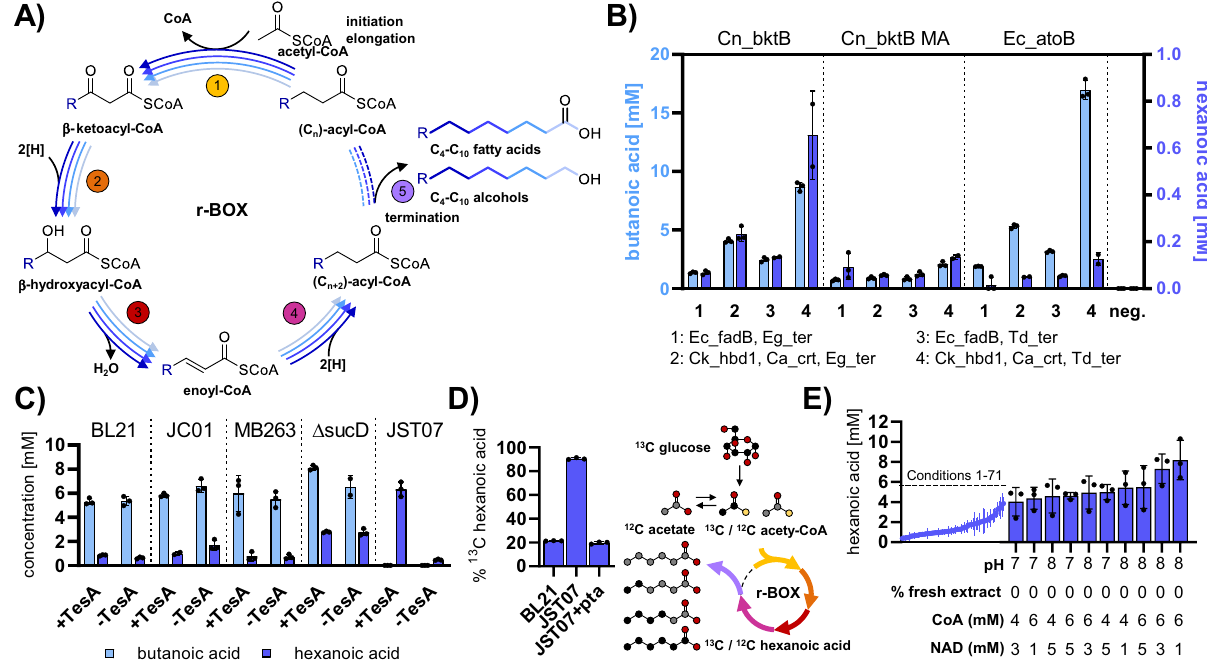
Fig. 1 Establishing a cell-free r-BOX platform. A General scheme of r-BOX. A thiolase (1) adds an acetyl-CoA unit every cycle to a growing acyl-CoA chain. The 3-keto group is then successively reduced (2), dehydrated (3) and reduced (4) again to form a two-carbon elongated acyl-CoA group. Termination enzymes (5) generate products from the acetyl-CoA intermediates of this iterative process. B Initial screen of r-BOX enzymes to establish a functional base case for in vitro hexanoic acid synthesis. All assays contained 0.3 μ M of each cycle enzyme and 0.15 μ M Ec_tesA. Conditions (i) Ec_fadB, Eg_ter; (ii) Ck_hbd1, Ca_crt, Eg_ter; (iii) Ec_fadB, Td_ter; (iv) Ck_hbd1, Ca_crt, Td_ter. The highest hexanoic acid production was observed for Cn_bktB, Ck_hbd1, Ca_crt, Td_ter, which was used in all future optimizations. C Thioesterase background activity from the extract strain used for iPROBE was assessed by omitting thioesterase Ec_tesA. D Carbon utilization assays using the base case of r-BOX enzymes with 120 mM 13 C glucose. The assay contains approximately 120 mM 12 C acetate from extract preparation and addition as CFME salts. % of 13 C label in the hexanoic acid product was determined by GC-MS. 13 C labeled carbons are shown in black, 12 C labeled carbons in gray. E Buffer, concentration of glycolytic enzymes, and cofactor optimization for the initial r-BOX set. Detailed results and full information on enzyme abbreviations in Source Data fi le. Data represent n = 3 independent experiments, with the standard deviation and mean